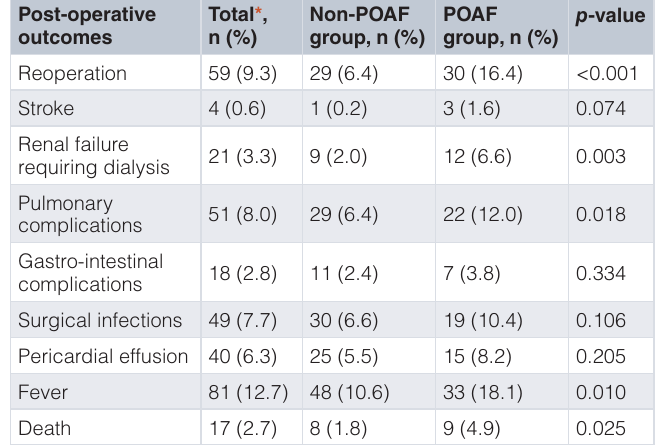
Table 8. Association between post-operative atrial fibrillation (POAF) and post-operative outcomes.